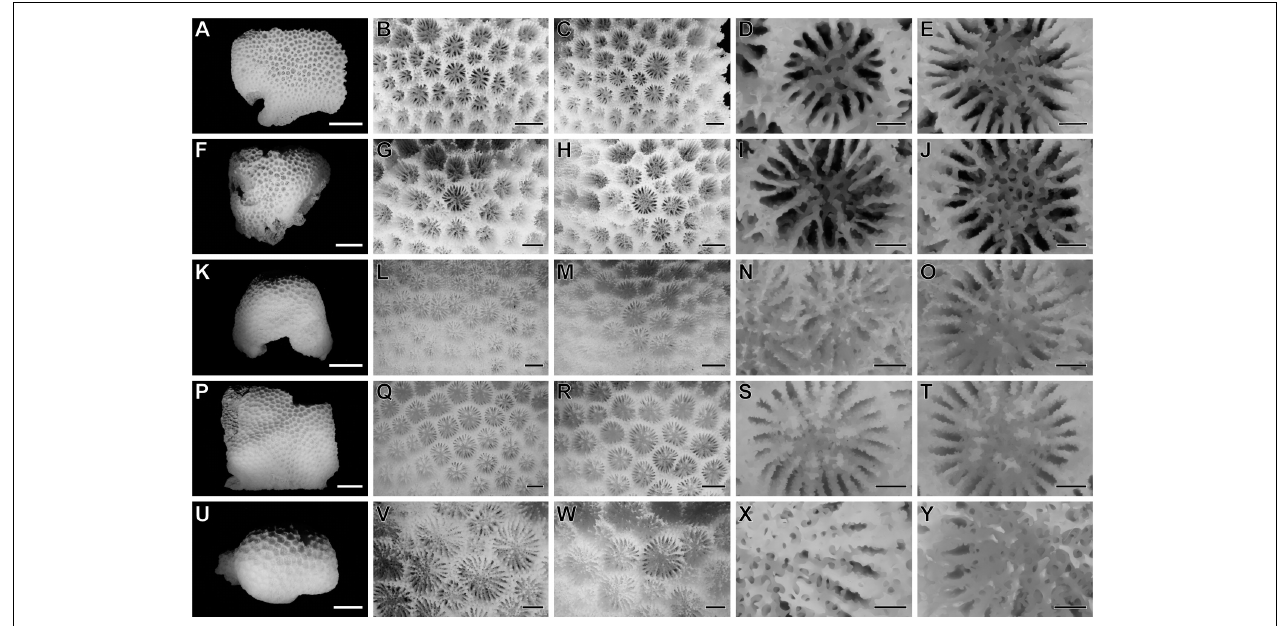
FIGURE 2 | Morphological variations in the Goniopora lobata c omplex. (A–E) Goniopora lobata (KS53), (F–T) Three different “intermediate” types of the two morphological species (F–J) : TN79, (K–O) : AM26, (P–T) : KK16, (U–Y) : Goniopora djiboutiensis (IR68). Corallum of each sample [ (A,F,K,P,U) , scale bar = 20 mm], major examples of calices in the corallum [ (B,C,G,H,L,M,Q,R,V,W) , for (A,F,K,P,U) , respectively, scale bar = 3 mm], close-up photography of calices [ (D,E,I,J,N,M,S,T,X,Y) , scale bar = 1